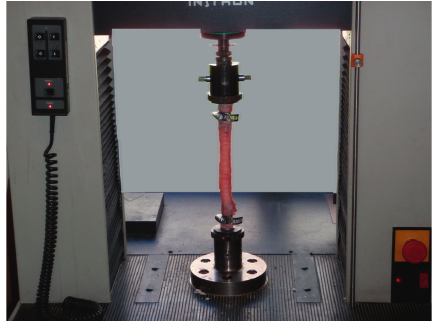
Figure 4: Testing arrangement of the trachea in a universal test machine.